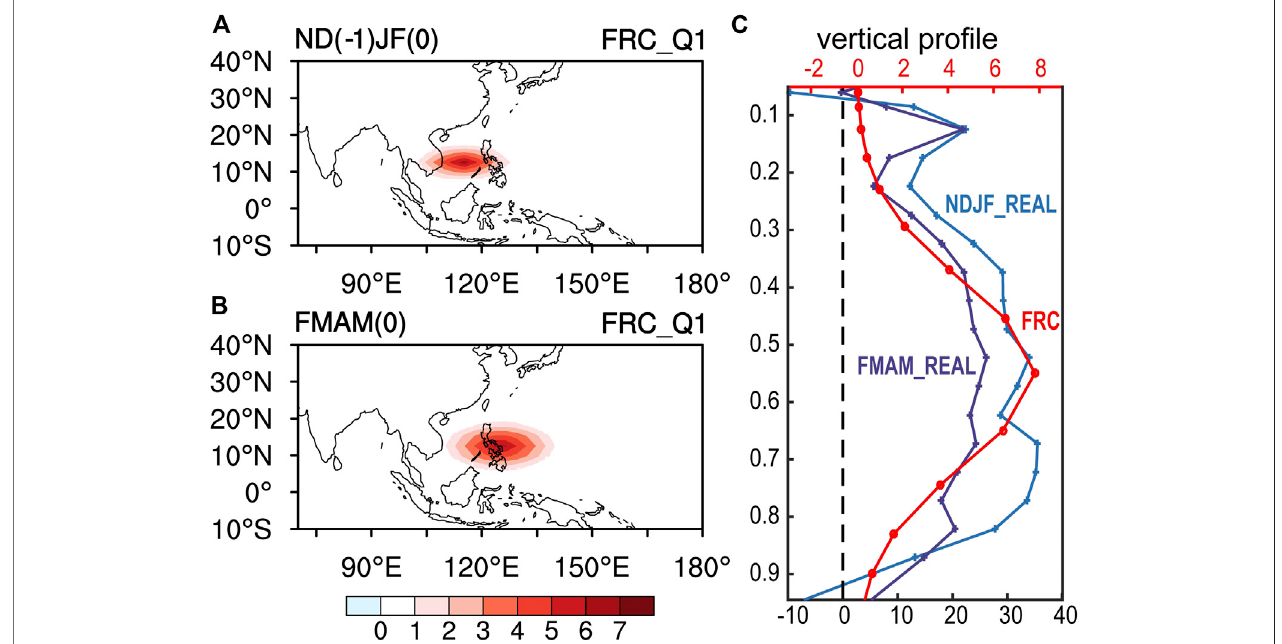
FIGURE 12 | Atmospheric heat source settings for the LBM numerical experiments. Horizontal distribution of the speci fi ed heat source (K/day) at the 0.55 sigma level in (A) November – February and (B) February – May. (C) Vertical pro fi les of the epochal differences of the area-averaged heat source observations (K, the lower abscissa) in the respective speci fi ed regions of (A) and (B) in November – February (NDJF_REAL, blue line) and February – May (FMAM_REAL, purple line), and the speci fi ed heat source at the forcing center (FRC, red line; K/day, the upper abscissa) in sigma coordinate.